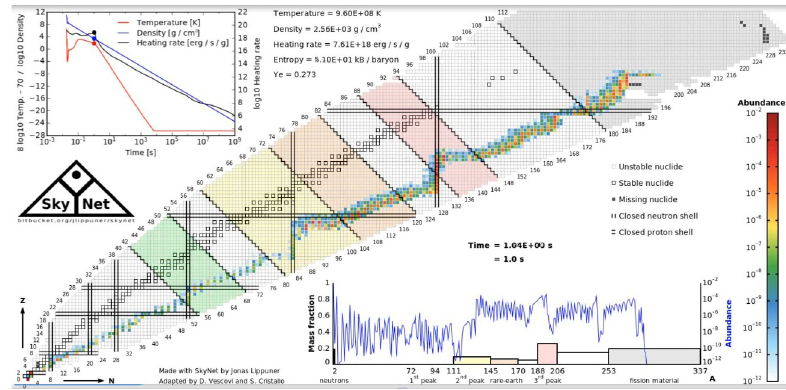
Figure 2. Typical pattern of the r-process. The plot has been produced with the PYTHON graphical interface of the SKYNET code